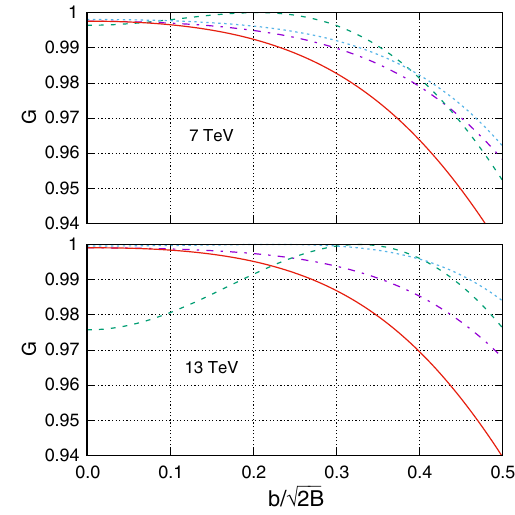
Fig. 3 Area near b = 0 of Figs. 1 and 2 in more details